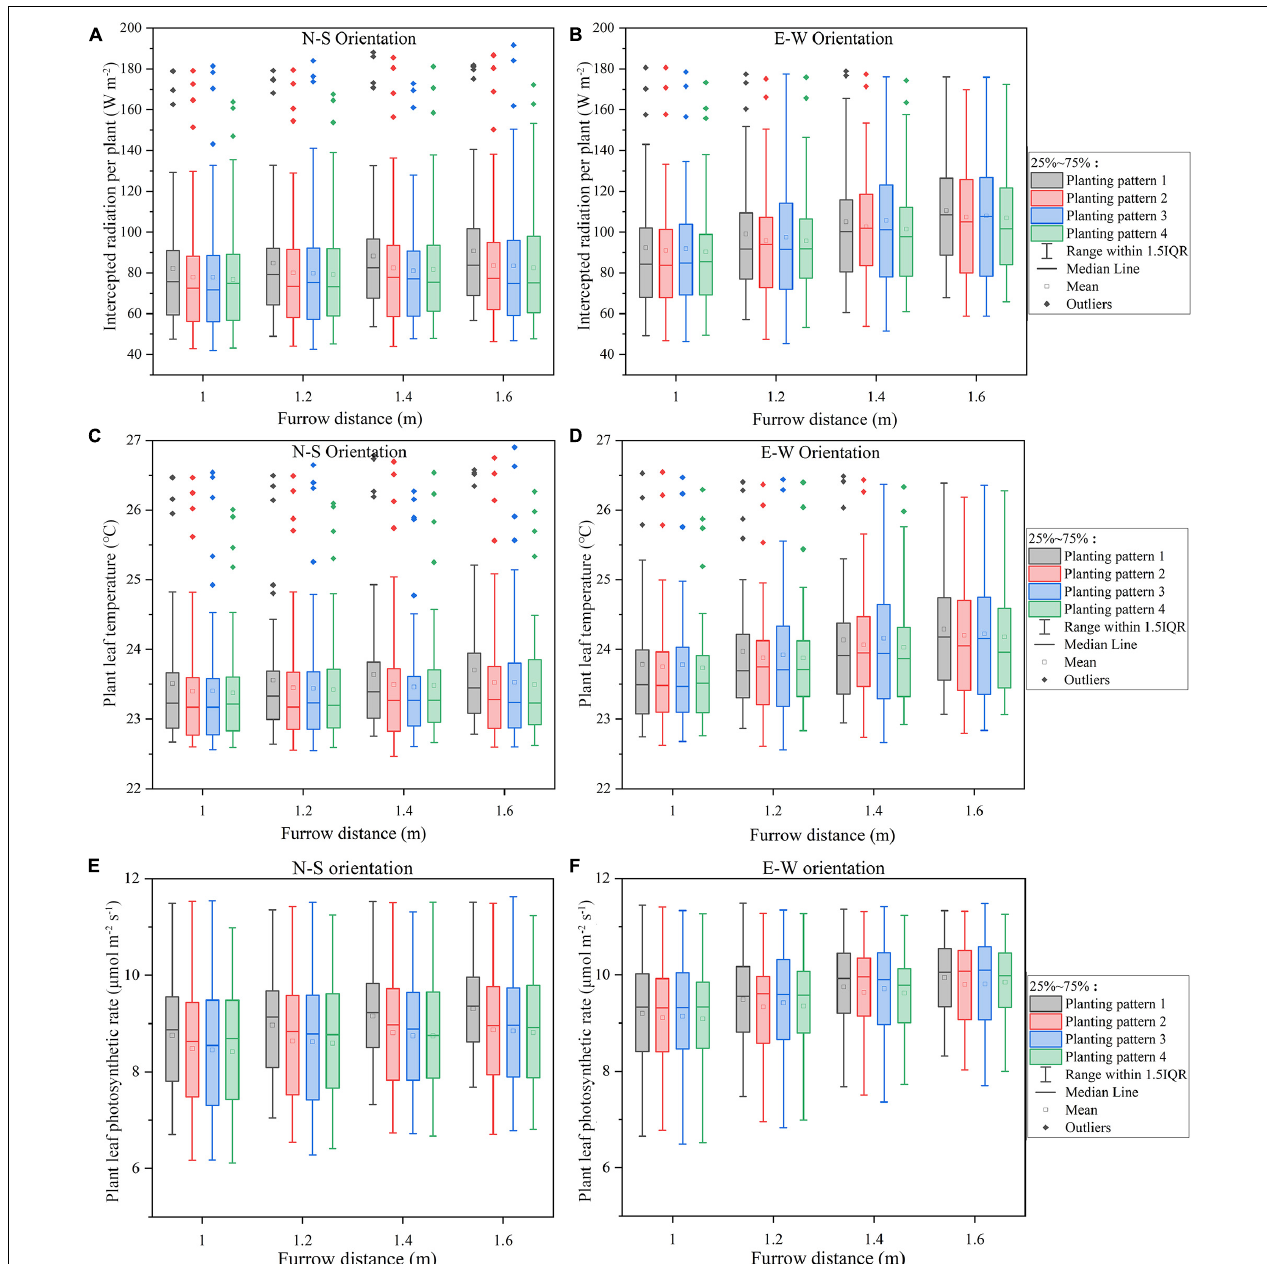
FIGURE 7 | The midday plant solar radiation interception (A,B) , leaf temperature (C,D) , photosynthesis (E,F) of the four planting patterns under N–S orientation (A,C,E) , and E–W orientation (B,D,F) as the furrow distance increases.